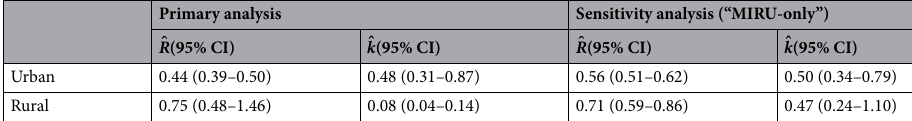
Table 2. Maximum likelihood estimates (MLE) for R and k by population. The primary analysis used epidemiologic, geospatial, and genotypic data to define transmission subclusters. The sensitivity analysis assumed MIRU-VNTR genotypic clusters were transmission